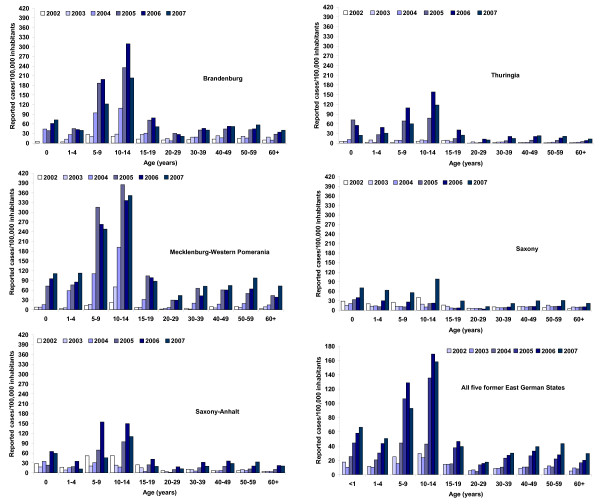
Pertussis incidence in former East German States 2002–2007 based on notification data according to state-specific infectious disease surveillance laws.